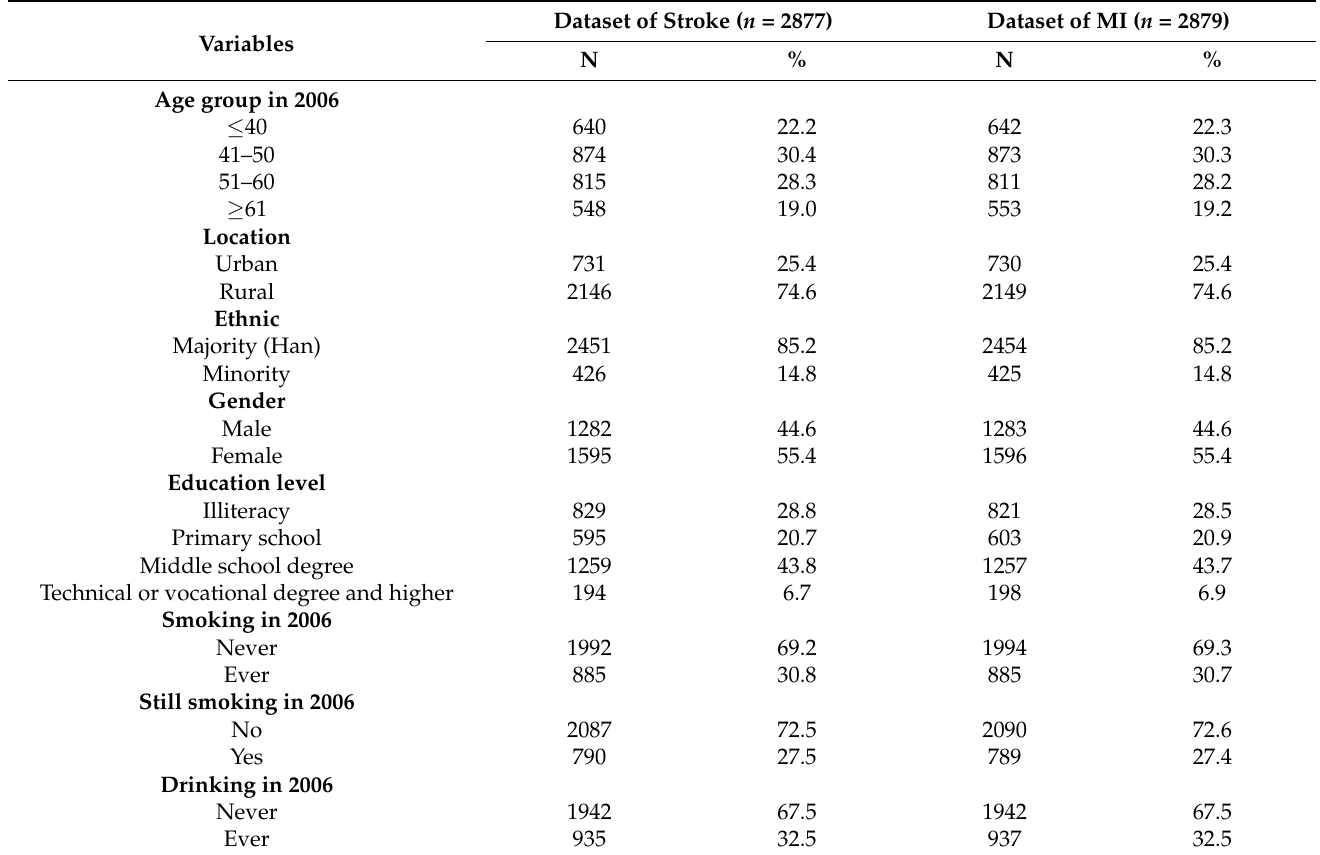
Table 1. The characteristics of the